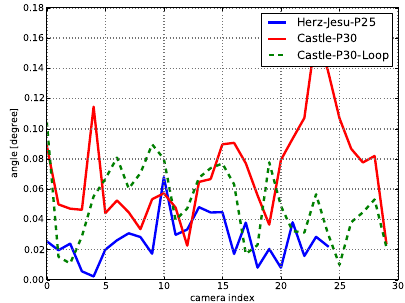
Figure 7: Angle error from Herz-Jesu-P25 and Castle-P30 with and without loop